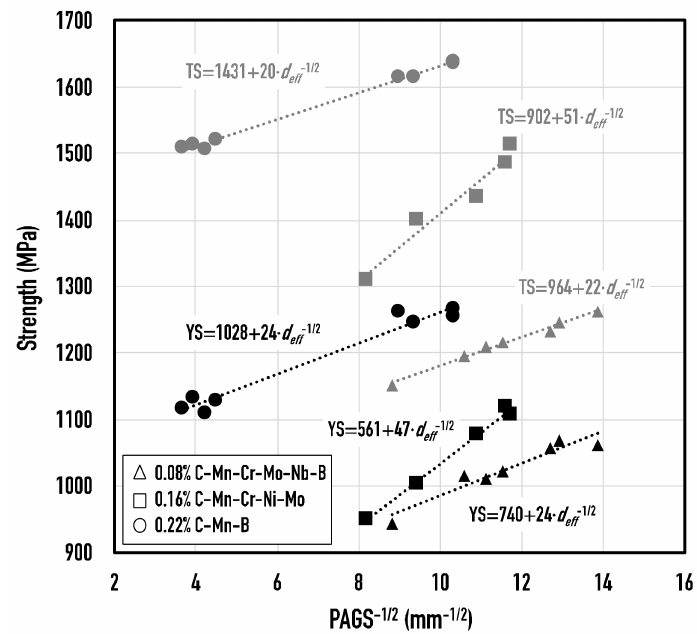
Figure 10. Hall–Petch type plot indicating the effect of parent austenite grain size (pancake thickness for direct quenched steels) on yield (black symbol) and tensile (grey symbol)